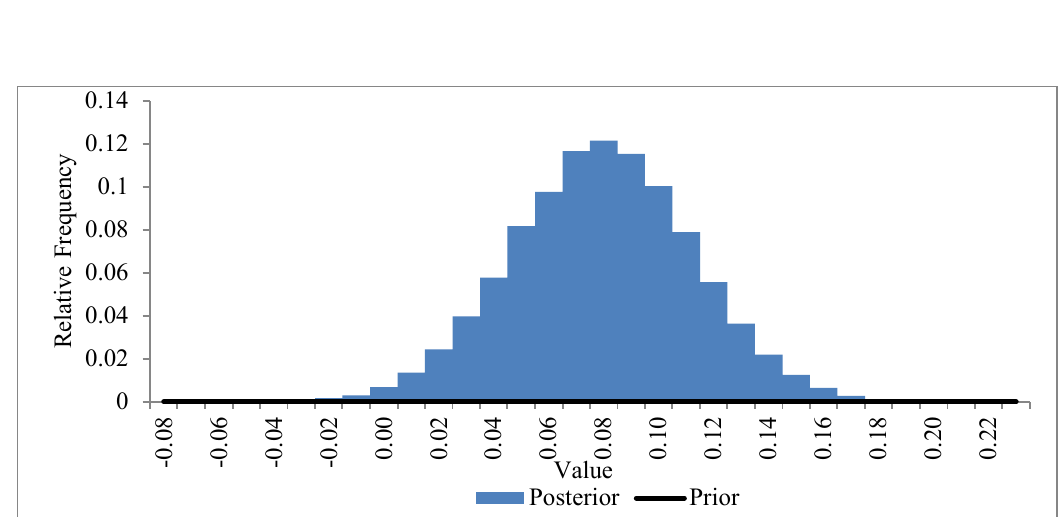
Fig. 10 . Posterior distribution of the Covid-19 variable